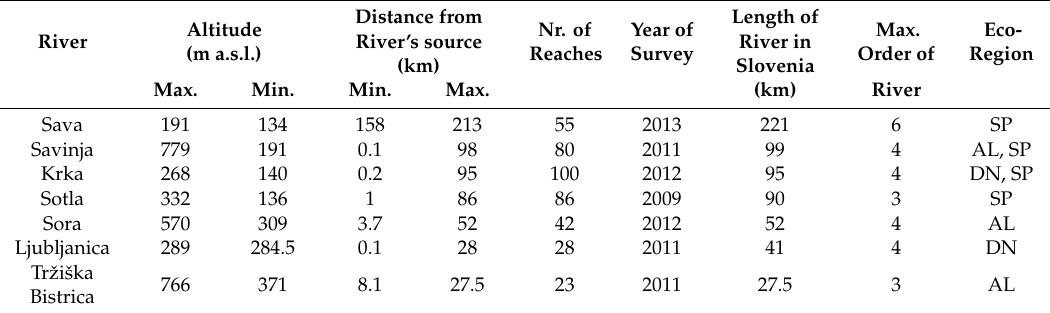
Figure 1. Geographical position of the study area in Slovenia ( A , left) and in Europe ( B , right). Table 1. The main characteristics of the 414 reaches of the rivers studied. Ecoregions: SP—sub-Pannonian, AL—Alpine, DN—Dinaric. Maximum order of the studied rivers in Slovenia is in accordance with Strahler [44].